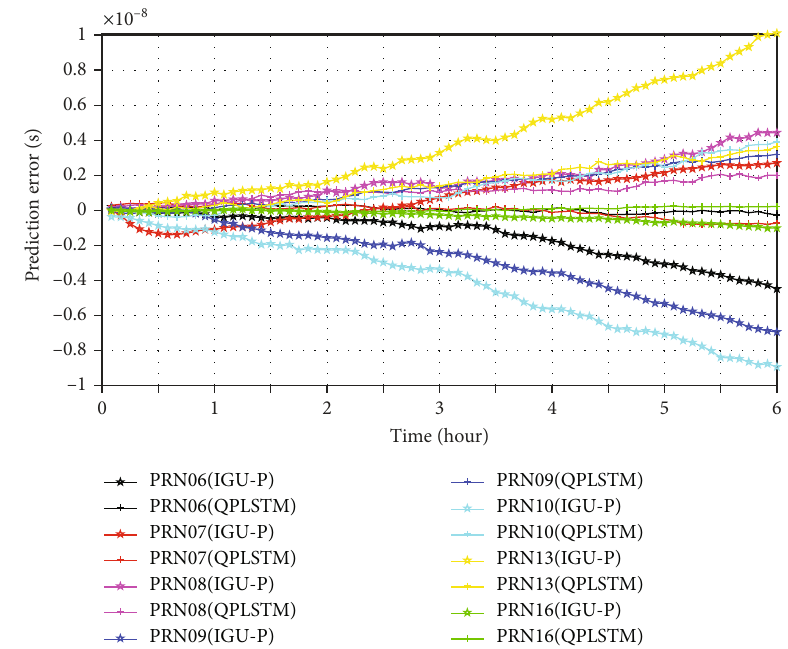
Figure 8: Prediction residuals for IGU-P and QPLSTM for